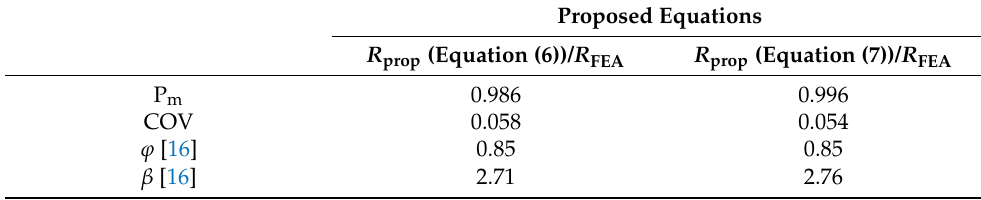
Table 3. Reliability analysis